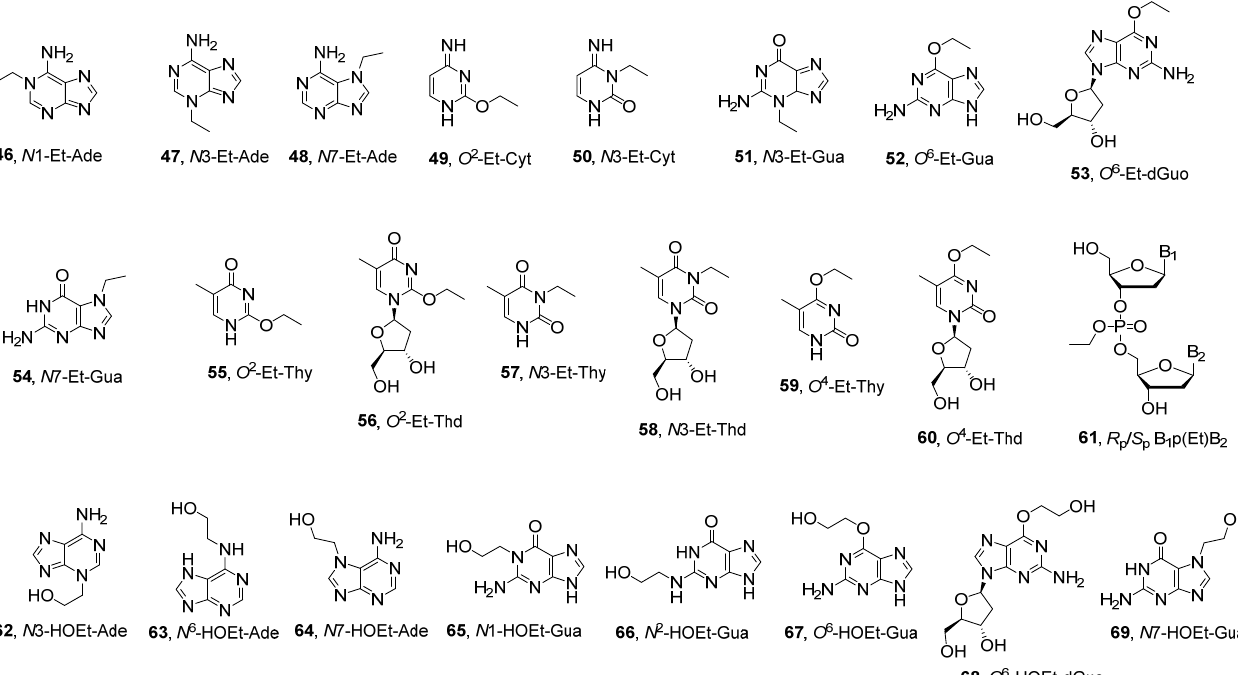
Figure 5. Structures of ethyl and hydroxyethyl DNA adducts.